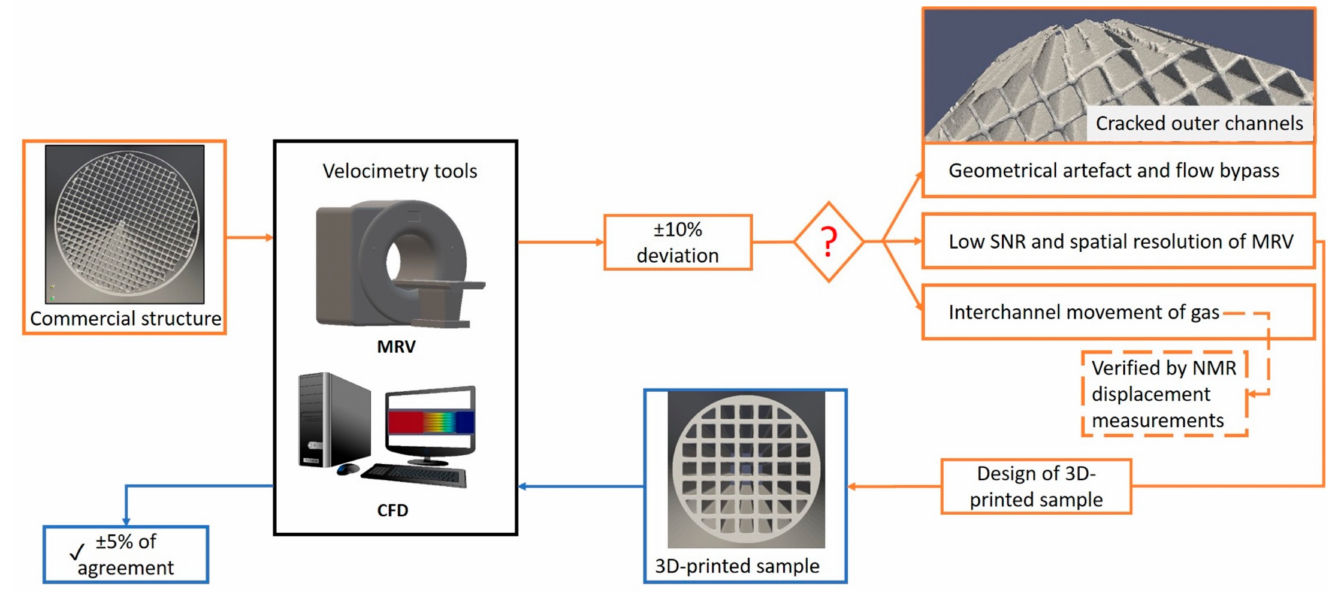
Figure 14. The overview of the conducted study for the analysis of gas flow within the honeycomb monoliths.